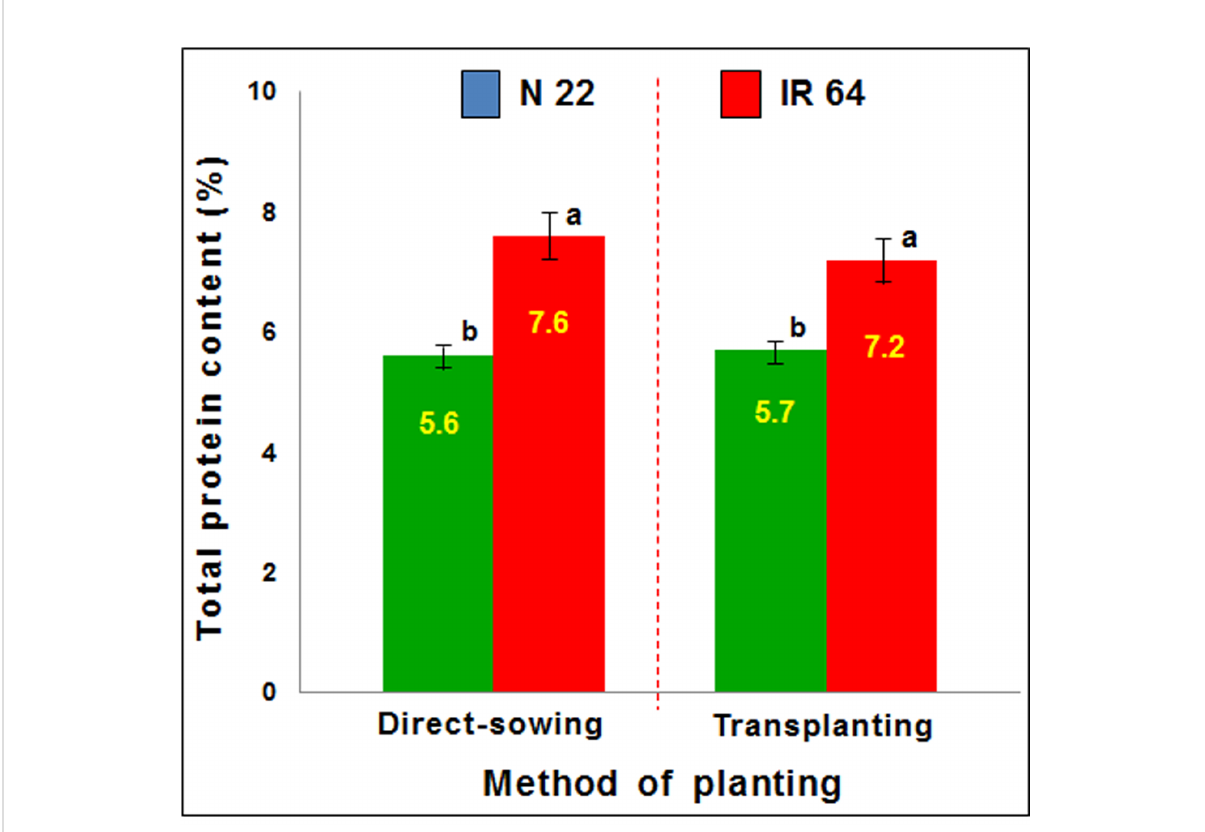
FIGURE 3 Effect of the methods of planting (direct-sowing and transplanting) on protein content in mature seeds. Data represent the mean ± SD (n = 3). Mean values followed by different lowercase letters (a, b) are signi fi cantly different (P ≤